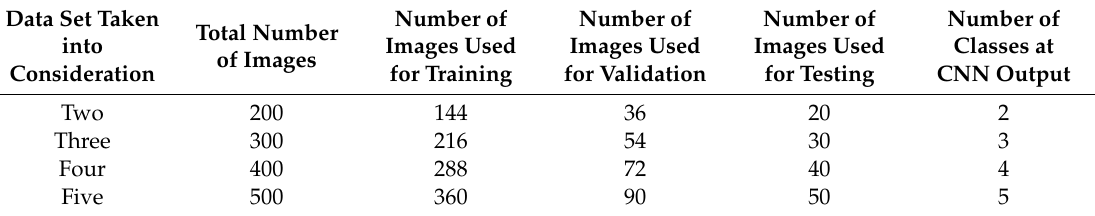
Table 3. EEG Scalogram Image Numbers Used for the CNN in Each Fold Cross-Validation.